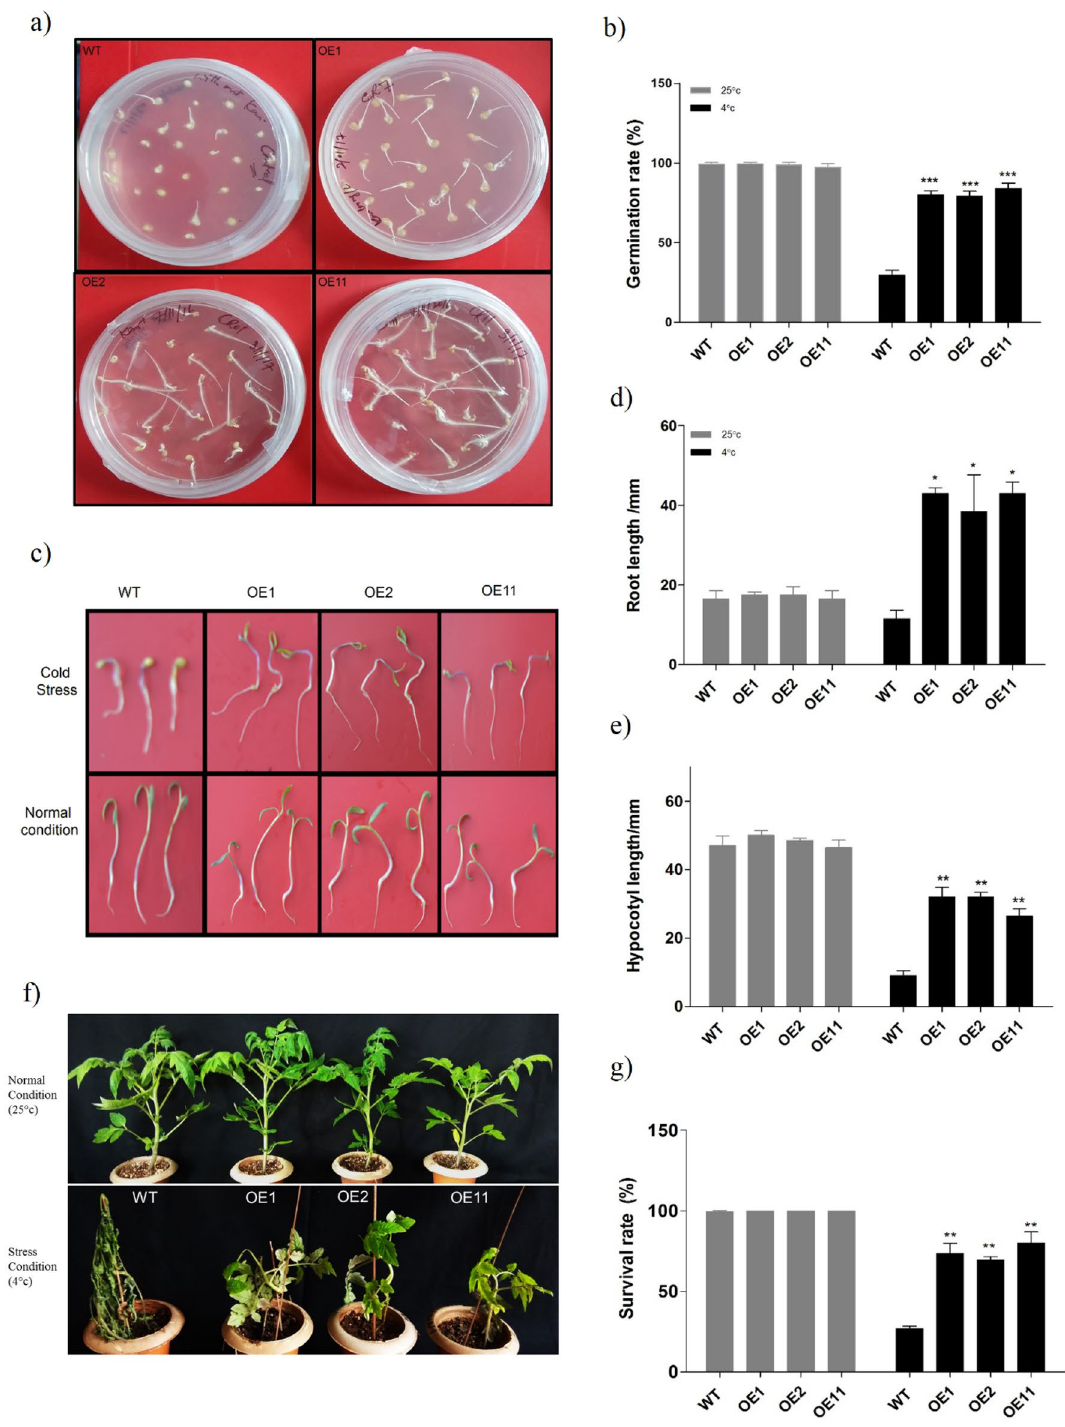
Figure 4. Low temperature induced stress tolerance in transgenic tomato plants over- expressing the BoCRP1 gene under cold stress. ( a ) Rate of germination of transgenic and wild-type seeds under cold stress (4 °C). The rate of seed germination were calculated at the times when root emerges from the seed and photograph was taken after 2 weeks at 4 °C. ( b ) Graphical representation of the mean of three independent experiments. In each individual experiment the rate of seed germination was averaged from a total of 26 seeds. ( c ) Root and hypocotyl development in early seeding of wild-type and transgenic plantlets under normal and stress conditions. ( d , e ) Graphical representation of average root and hypocotyl length of transgenic and wild-type seedlings. ( f ) Phenotypic evaluation of tomato plants under Ambient Temperatures (25 °C) after recovery for 2 days post cold stress (4 °C) treatment for 4 days. The photograph was taken after 2 days of recovery. ( g ) Represents the survival percentage of WT, OE1, OE2 and OE11 plants during recovery after cold treatment for 4 days. Data represents the average of 3 independent experiments. A total of 100 plants of each line including wild-type were used for the experiment. The bars indicates standard deviation (SD) and Asterisks represents significant differences between wild-type and transgenic lines. * P < 0.05; ** P < 0.01; *** P < 0.001 Tukey’s Multiple Comparison